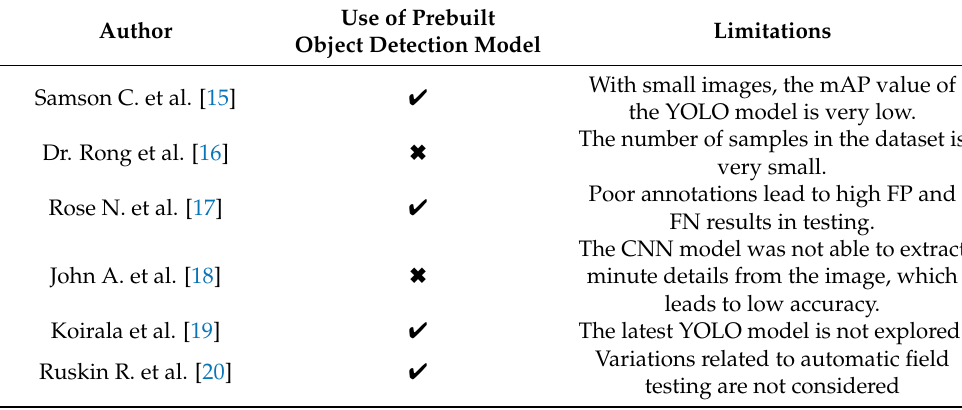
Table 1. Summary of related